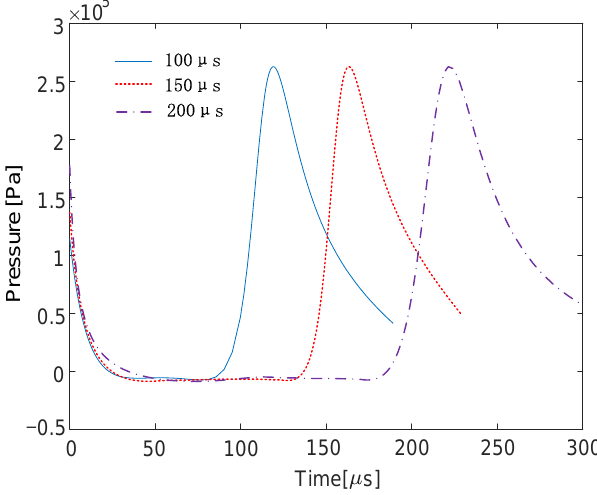
Figure 4. Different negative pressure period of driving pressure. The maximum bubble radius relates with the negative pressure period, and is in- directly affected by boundary vibration velocity and gap clearance. Figure 5 shows the maximum bubble radius changing with initial radius and standoff distance at different negative pressure period. The initial radius and standoff distance are set from 10 µ m to 60 µ m and 100 µ m to 5000 µ m, respectively. Generally the maximum radius increases with both initial bubble radius and standoff distance, therefore the maximum bubble radius appears when distance equals 5000 µ m and initial radius equals 60 µ m in this case. For 100 µ s negative pressure period, the peak of maximum radius is 301 µ m, while at 150 µ s, the peak maximum bubble radius is 414 µ m. The largest maximum radius is found to be 522 µ m at 200 µ s. The curve of maximum radius corresponding to 100 µ s is covered by 150 µ s, and curve of 200 µ s is on the top. The interval between them is about 100 µ m. Along the direction of distance, the maximum radius increases rapidly at beginning then slows down especially when distance is over 1000 µ m as shown in Figure 6. With larger negative pressure period, the slope of curve is more abrupt with distance under 500 µ m.